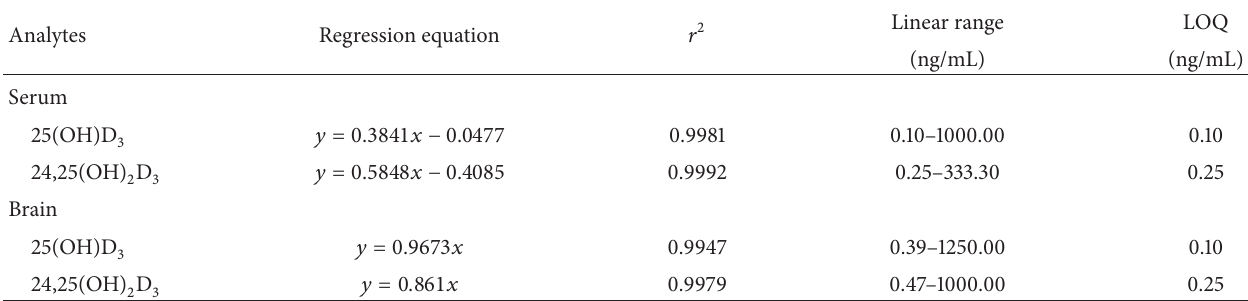
Table 2: Calibration statistics.